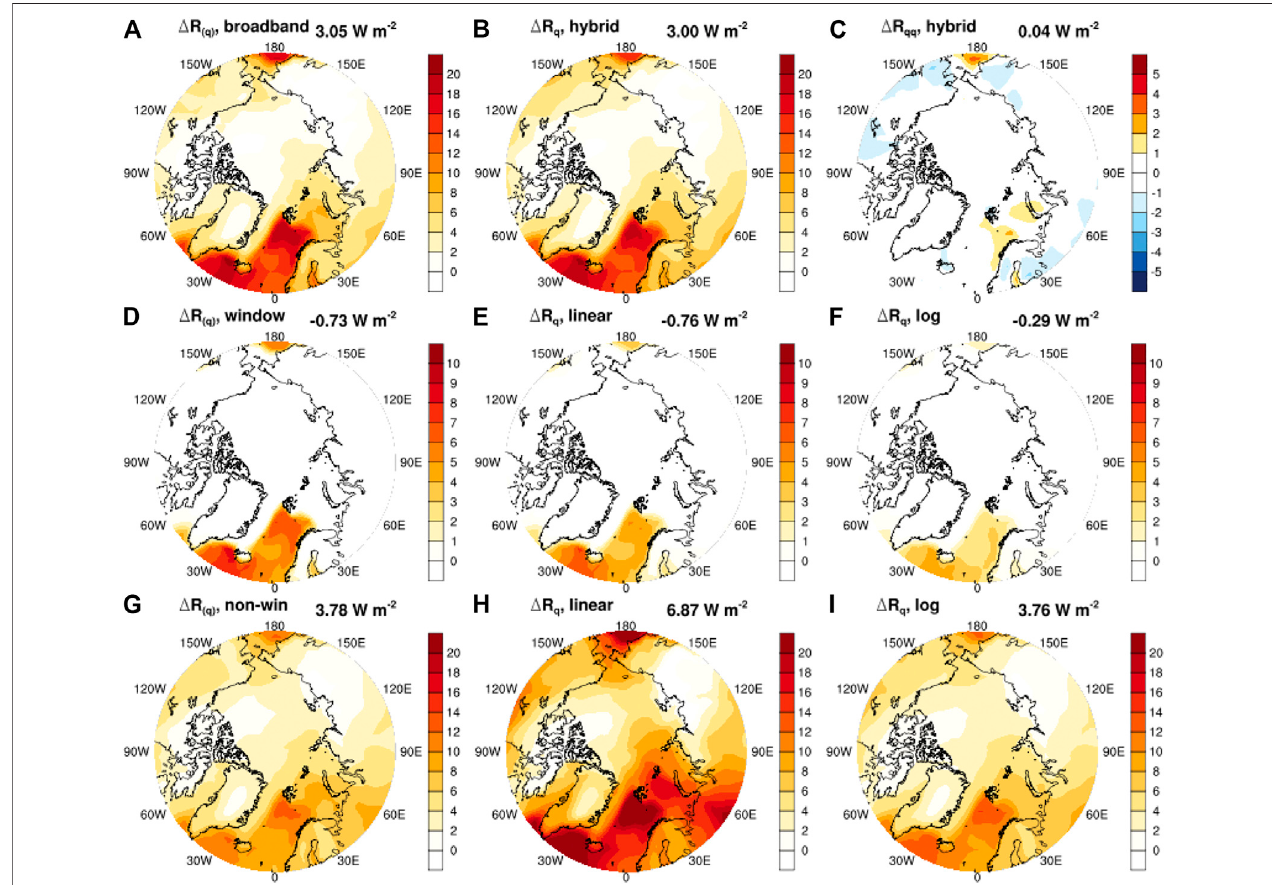
FIGURE 5 | Spectral breakdown of the clear-sky univariate water vapor feedback. (A) RTM-computed (truth) broadband univariate feedback, Δ R ( q ) ; (B) kernel- diagnosed broadband feedback, Δ R q , using the hybrid scaling ( Eq. 10 ); (C) residual, Δ R qq . (D – F) Window band (700 – 1,180 cm − 1 ) feedback, computed by RTM and estimated by linear and logarithmic scaling. (G – I) Like (D – F) , but for the non-window (absorption) bands.